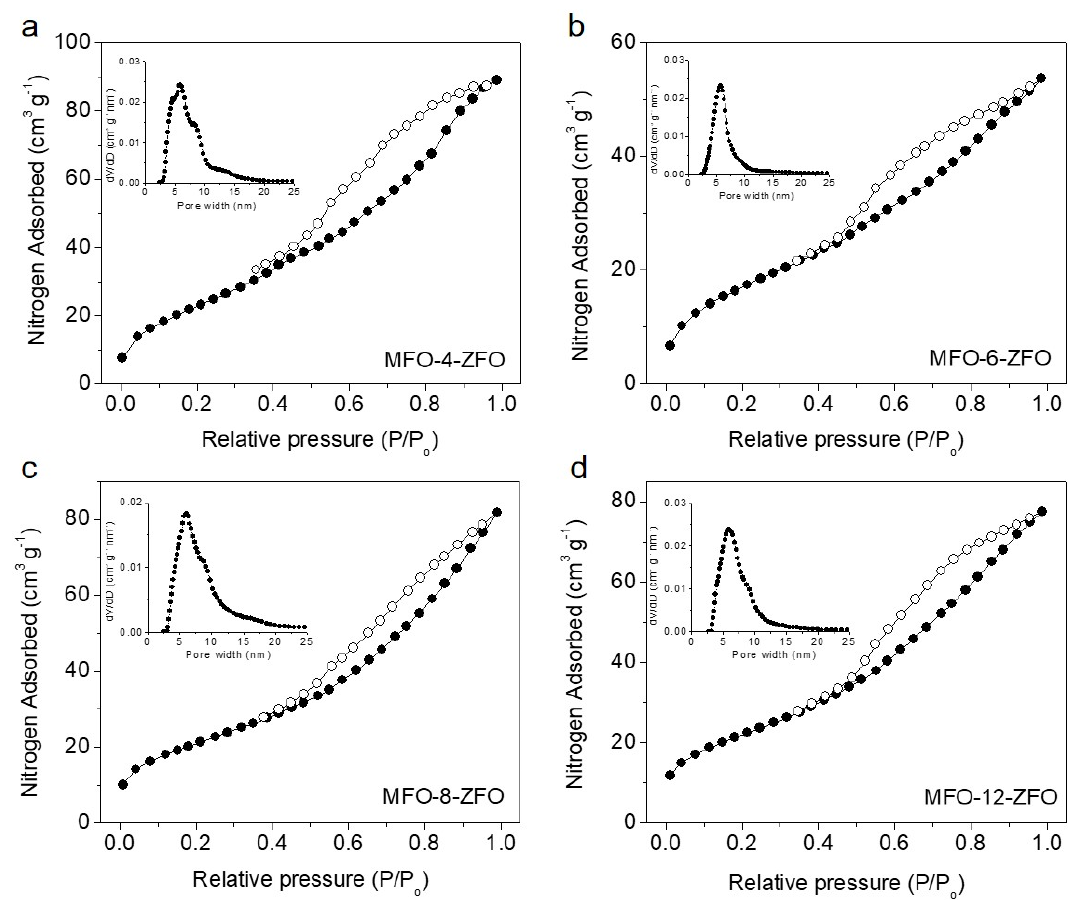
Figure 2. N 2 adsorption (solid symbols) and desorption (open symbols) isotherms at − 196 °C and the corresponding NLFDT pore-size distribution plots calculated from the adsorption branch of the isotherms (inset) for the MFO-ZFO catalysts: ( a ) MFO-4-ZFO, ( b ) MFO-6-ZFO, ( c ) MFO-8-ZFO and ( d ) MFO-12-ZFO.